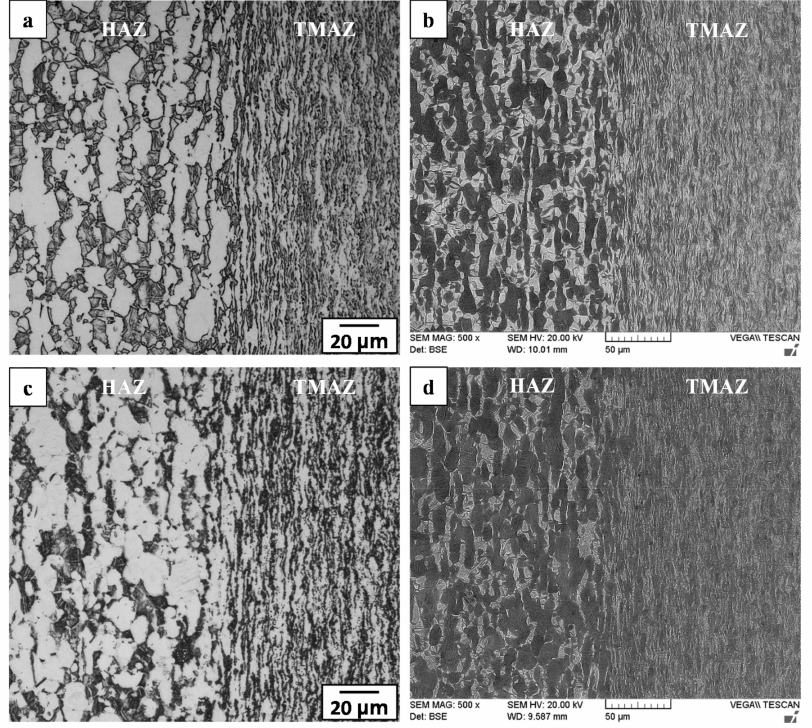
Figure 6. HAZ and TMAZ in Ti-6242 welds: ( a , b ) AWed (OM and SEM) and ( c , d ) SRAed (OM and SEM). The transformation of the metastable β phase in α + β titanium alloys can be explained by the role of alloying element partitioning on phase transformations during thermal processing. In titanium alloys, it is well known that aluminum stabilizes the α phase, while the β phase is stabilized strongly by vanadium and, in the case of Ti-6242, molybdenum. Recently, Huang et al. [53] studied the partitioning of elements in α and β and reported nearly constant levels in the primary- α phase, whilst the element concentration varied in the transformed β structure and depended on the β phase volume fraction at the onset of cooling. For Ti-6242, H é mery and Villechaise [54] reported that molybdenum concentrates by a factor of 2-3 in the β phase, while its solid solubility in the α phase is <0.7%. Additionally, the work of Bagariatskii et al. [55] and, recently, Dobromyslov and Elkin [56], has indicated that molybdenum concentrations between 5% and 8% in titanium alloys can fully stabilize the β -phase at room temperature during rapid